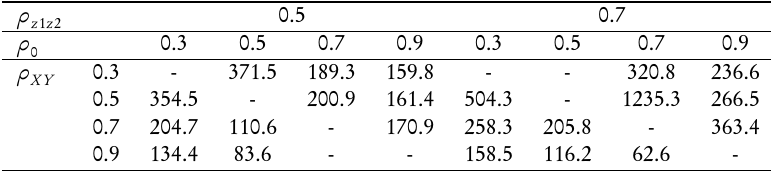
, ρ and ρ 0 z 1 z 2 XY